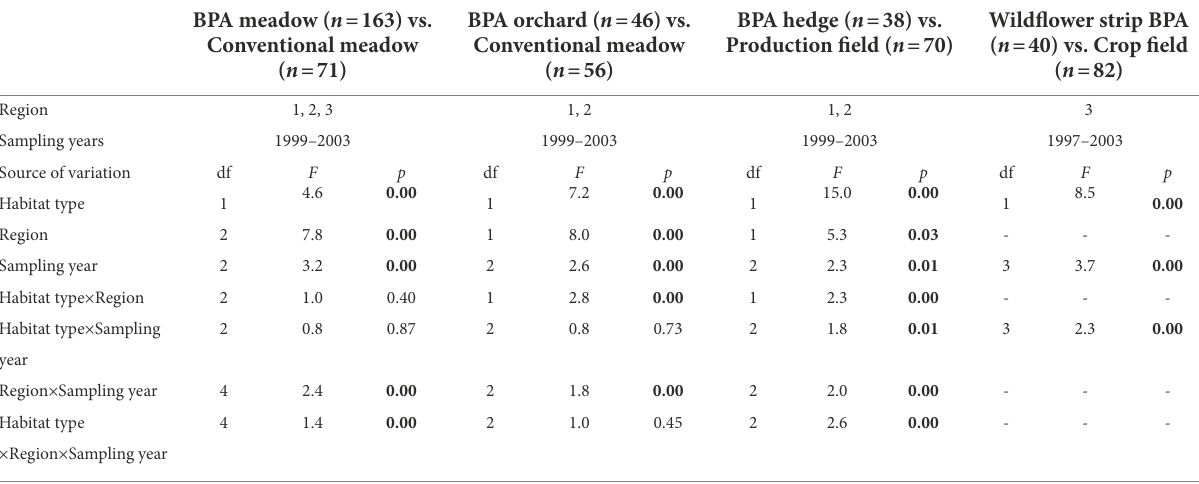
TABLE 2 Effects of habitat type pairwise (BPA habitat types vs. conventionally managed fields), region and sampling year on the species composition (beta-diversity) of spiders in three regions of the Swiss plateau (distance-based multivariate ANOVA with permutations, mixed-model). BPA meadow ( n = 163) vs. BPA orchard ( n = 46) vs. Conventional meadow Conventional ( n = 71)